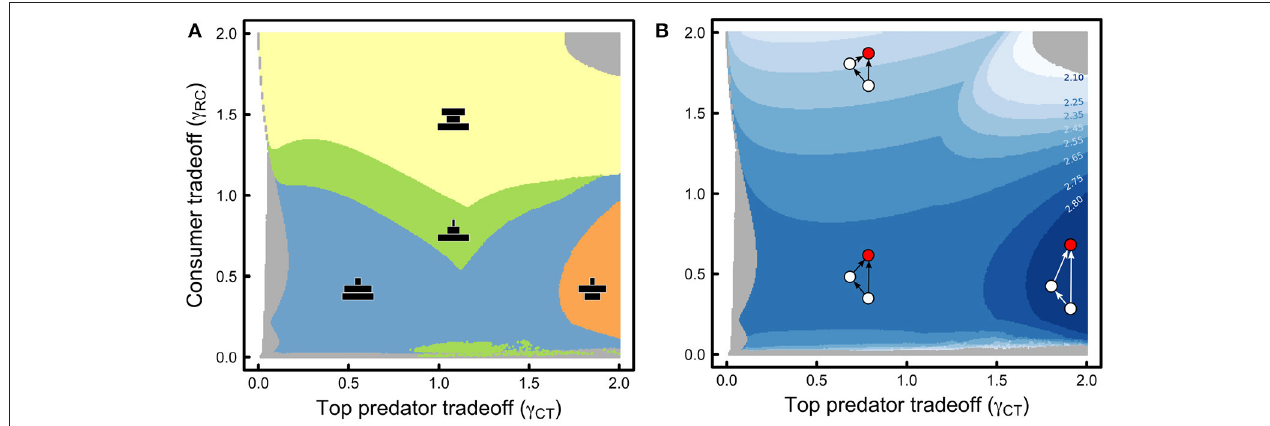
FIGURE 3 | (A) Plot of discretized changes in the abundance structure of the omnivory food web module assessed across all combinations of the consumer tradeoff ( γ RC ), and the top predator tradeoff ( γ CT ). A qualitative depiction of the abundance structure appears in black within each discrete region. (B) Discretized plot of the continuous changes in maximum trophic level (trophic level of the top predator, depicted in red), as the top predator and consumer tradeoffs change. Numbers indicate the trophic level of the top predator at each boundary. Gray areas indicate regions where coexistence is not feasible in (A,B) . Parameter values as in Table 1